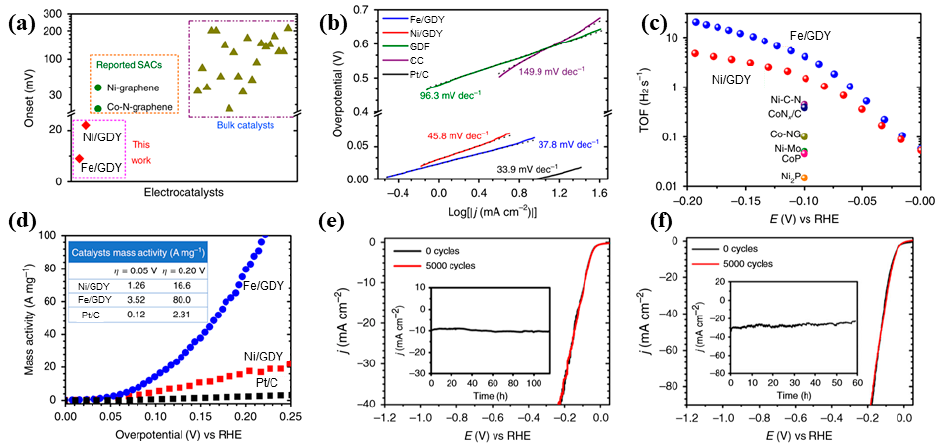
Figure 16. Electrochemical characterizations of Ni / GDY and Fe / GDY. ( a ) Onset values at 10 mA cm − 2 of Ni / GDY and Fe / GDY (red square) along with other nonprecious single-atom HER catalysts (green circle) and several bulk catalysts (olivine triangle); ( b ) Tafel plots of the presented data in ( a ); ( c ) TOF values of Fe / GDY (blue dot) and Ni / GDY (red dot) together with several state-of-the-art HER electrocatalysts; ( d ) mass activities of Ni / GDY, Fe / GDY and Pt / C (inset: mass activities obtained at overpotentials of 0.05 V and 0.20 V). Stability tests of ( e ) Ni / GDY and ( f ) Fe / GDY (insets: respective time-dependent current density curves) (reproduced with permission from [67]. Copyright Springer Nature, 2018). Table 2. HER performance of metal-atom-anchored GDY.